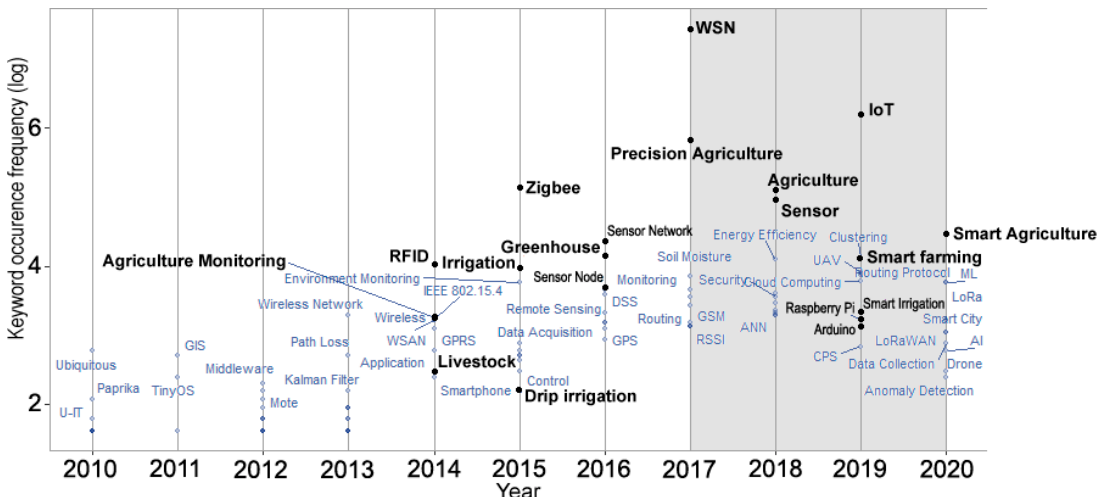
Figure 3. WSN in agriculture, trending topics in scientific publications [11].